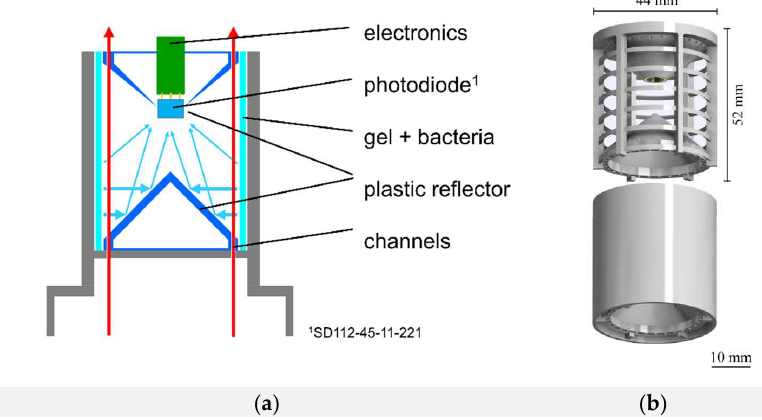
Figure 7. Working principle of the 2,4-DNT biosensor prototype 3.0. The sensor was placed upon contaminated soil and 2,4-DNT rich air is transported into the sensor via a miniature fan. Gene expression is triggered by 2,4-DNT and luciferase is produced. Emitted bioluminescence is focused with the help of two conic reflectors which reflect the light into the embedded photodiode ( a ). Prior to measurements, recombinant cells were immobilized within an agarose hydrogel matrix held by a cage and placed in a case ( b ).